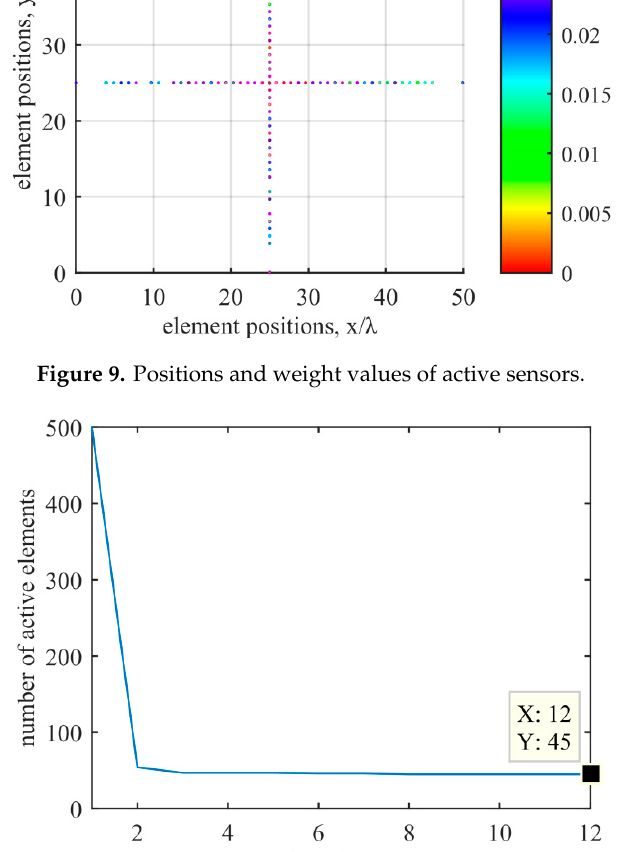
Figure 10. Number of active sensors versus the number of iterations.